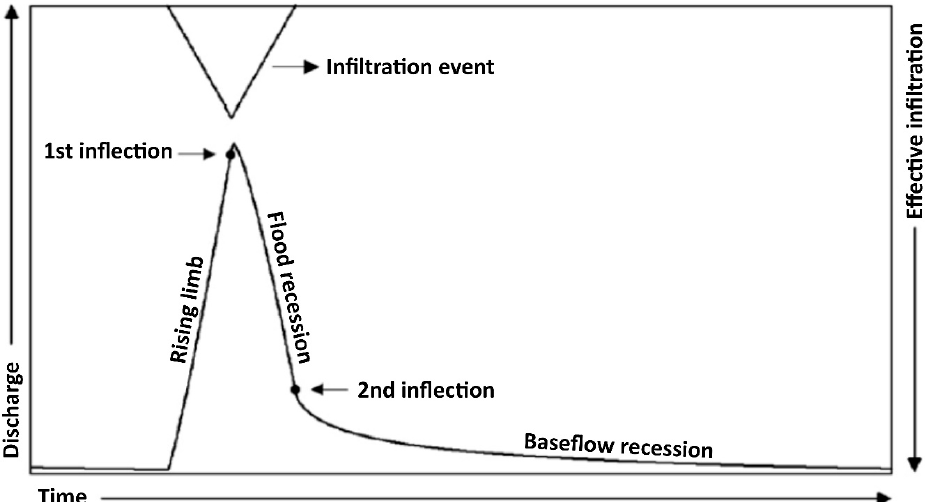
Figure 1. A graphical representation of spring hydrograph components. The first inflection point shows the maximum infiltration state, and the second inflection point represents the end of the infiltration event